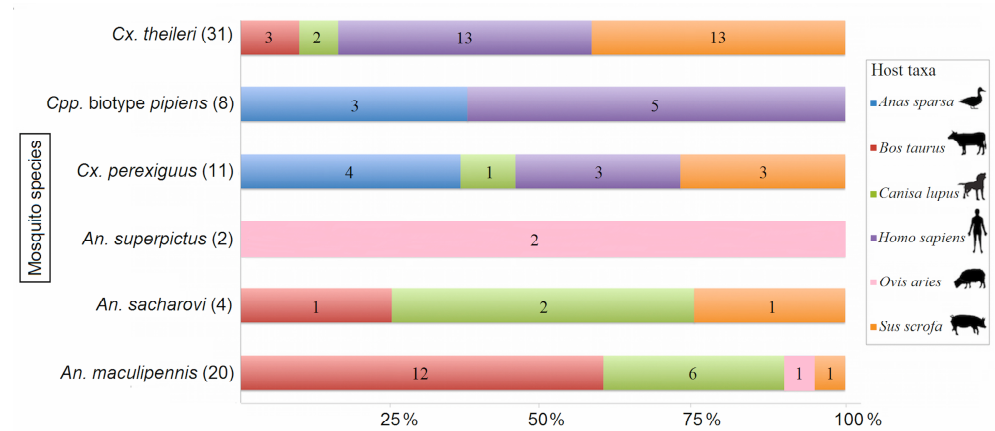
Figure 2. Host-feeding behavior of blood-fed mosquitoes from Western Iran.